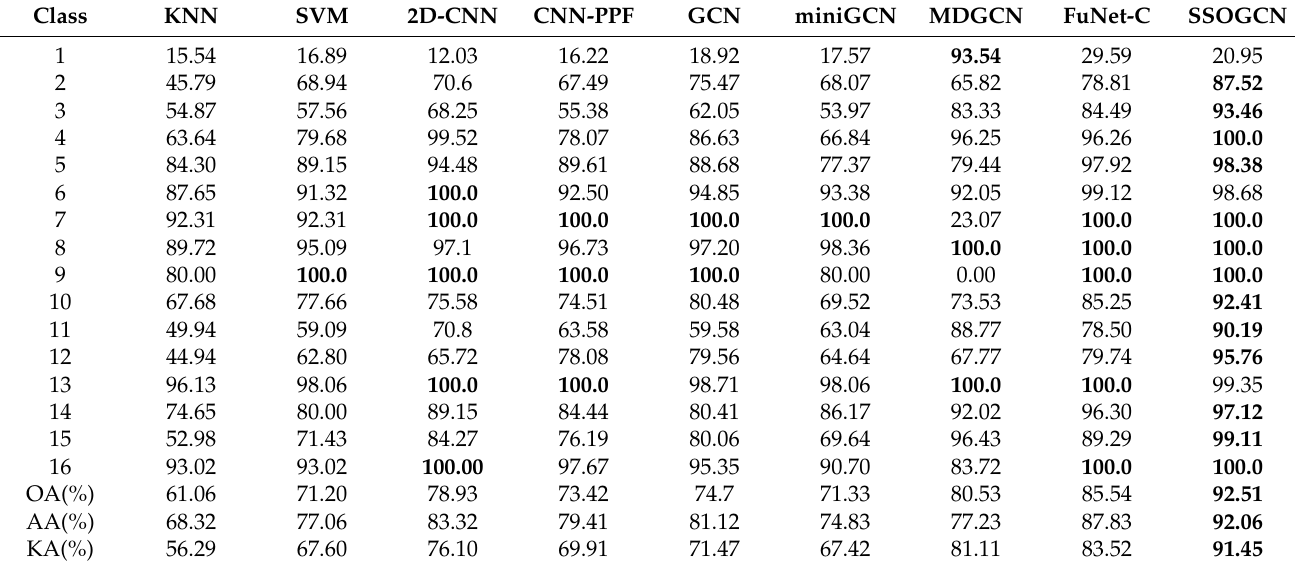
Table 5. Classification performance of various methods in Indian Pines data set (%).